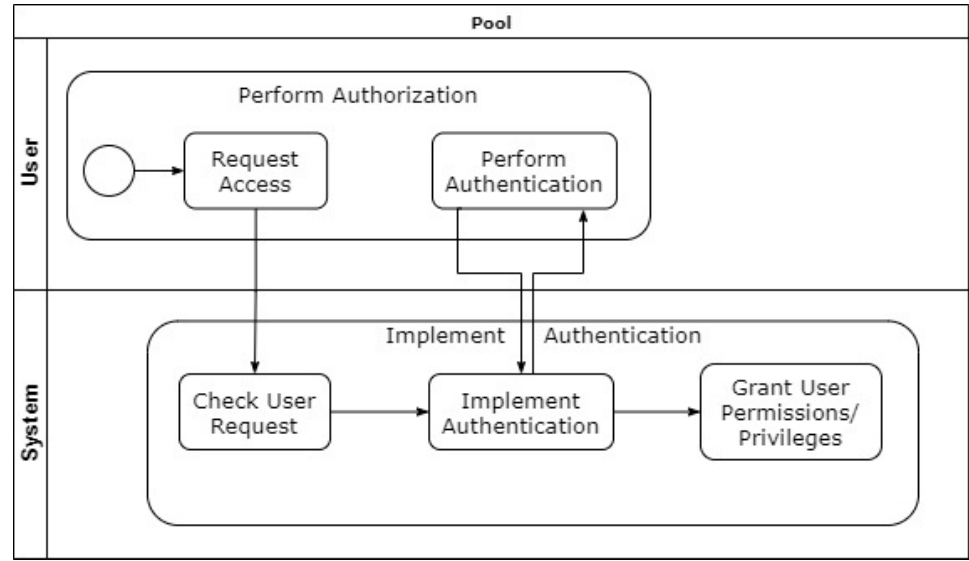
Figure 11. Conceptual overview of Authorization Process pattern [49].